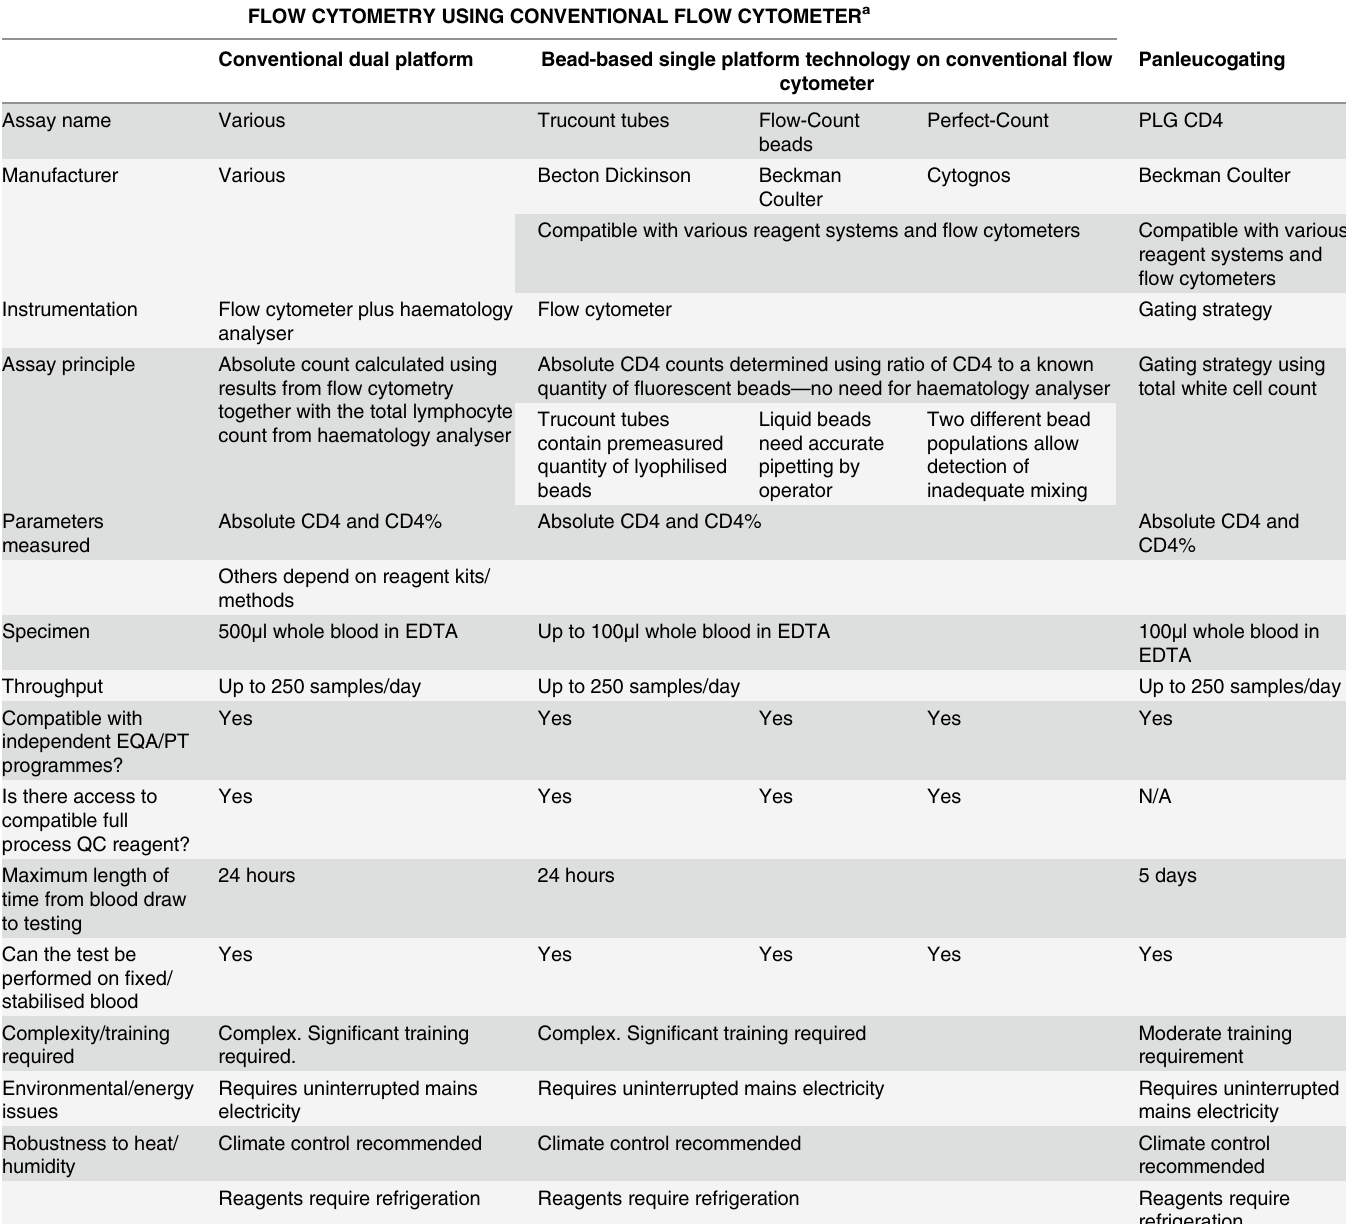
Table 1. Operating characteristics of fl ow cytometric methods for CD4+ T-cell enumeration, using conventional fl ow cytometers. FLOW CYTOMETRY USING CONVENTIONAL FLOW CYTOMETER a Conventional dual